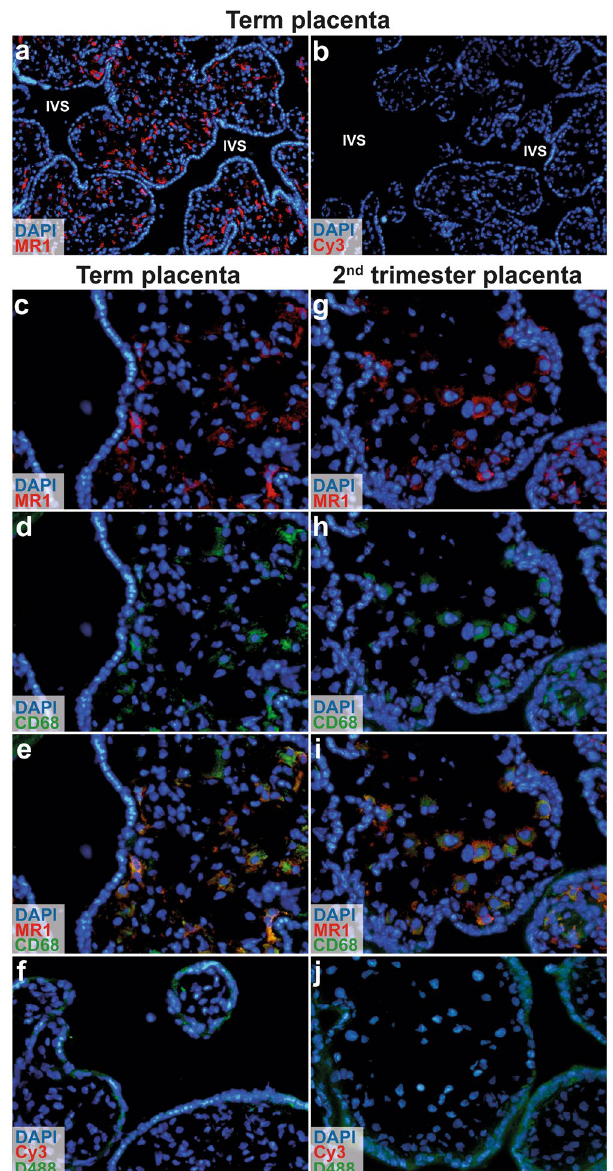
Figure 5. MR1 is expressed by macrophages in foetal villi, but not in syncytiotrophoblasts. Immunofluorescence microscopic images of term placental tissue showing cross sections of chorionic villi and intervillous space (IVS) stained with ( a ) MR1 (red) or ( b ) secondary antibody only (control) at magnification × 10. MR1 was expressed by cells inside the villi, but not in syncytiotrophoblasts. Sections of placental villi at ( c – e ) term and ( g – i ) gestation week 13 were stained for MR1 (red) and CD68 (green) ( × 20). ( e and i ) Merged images showed that MR1 and CD68 were coexpressed by cells in the villi. Sections stained only with secondary antibody (Cy3) and DyLight488-conjugated (D488) streptavidin complex were used as negative controls ( f and j ) ( × 20). Nuclei were stained with DAPI (blue). The same microscopy settings were kept for the samples and the corresponding controls, n = 2 for term placentas and n = 1 for 13 week